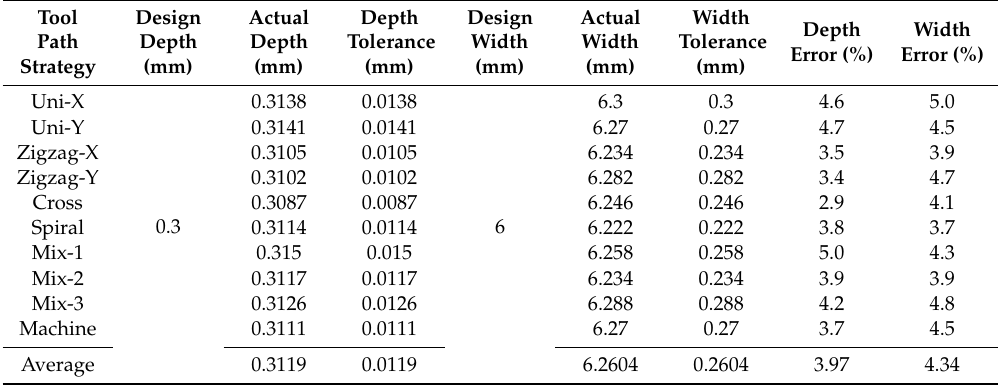
Table 6. Results of dimensional accuracy of the machined pockets.